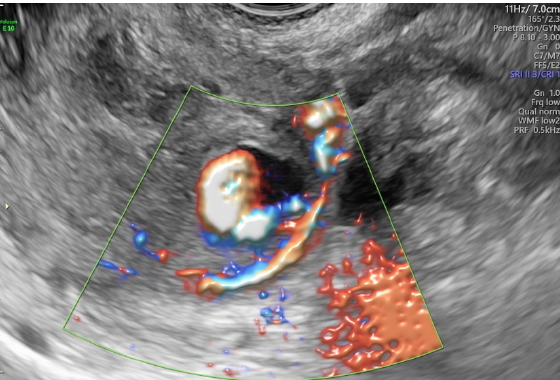
Figure 2. Acquired pseudoaneurysm from the ascending branch of the left uterine artery. Note the to-and-fro sign and the yin-yang image. The pelvic angiography, performed through retrograde left femoral access and catheterization of the left hypogastric artery, identified the left internal iliac artery and the distal branch of the ascending left uterine artery (Figure 3A). A nearby intramyometrial tubuliform dilatation appeared with a slightly smaller diameter and a different morphology than the previous ultrasound image. A contiguous intramyometrial contrast media diffusion presumably occurred shortly before the arteriography was performed as a possible expression of initial extravasation due to a probable rupture with blood transfer. Fortunately, the rupture zone occurred medially to the lesion in the intramyometrial zone and not towards the uterine serosa, where the lesion was very close. Otherwise, if the blood found a way out without resistance, the bleeding could be life- threatening.